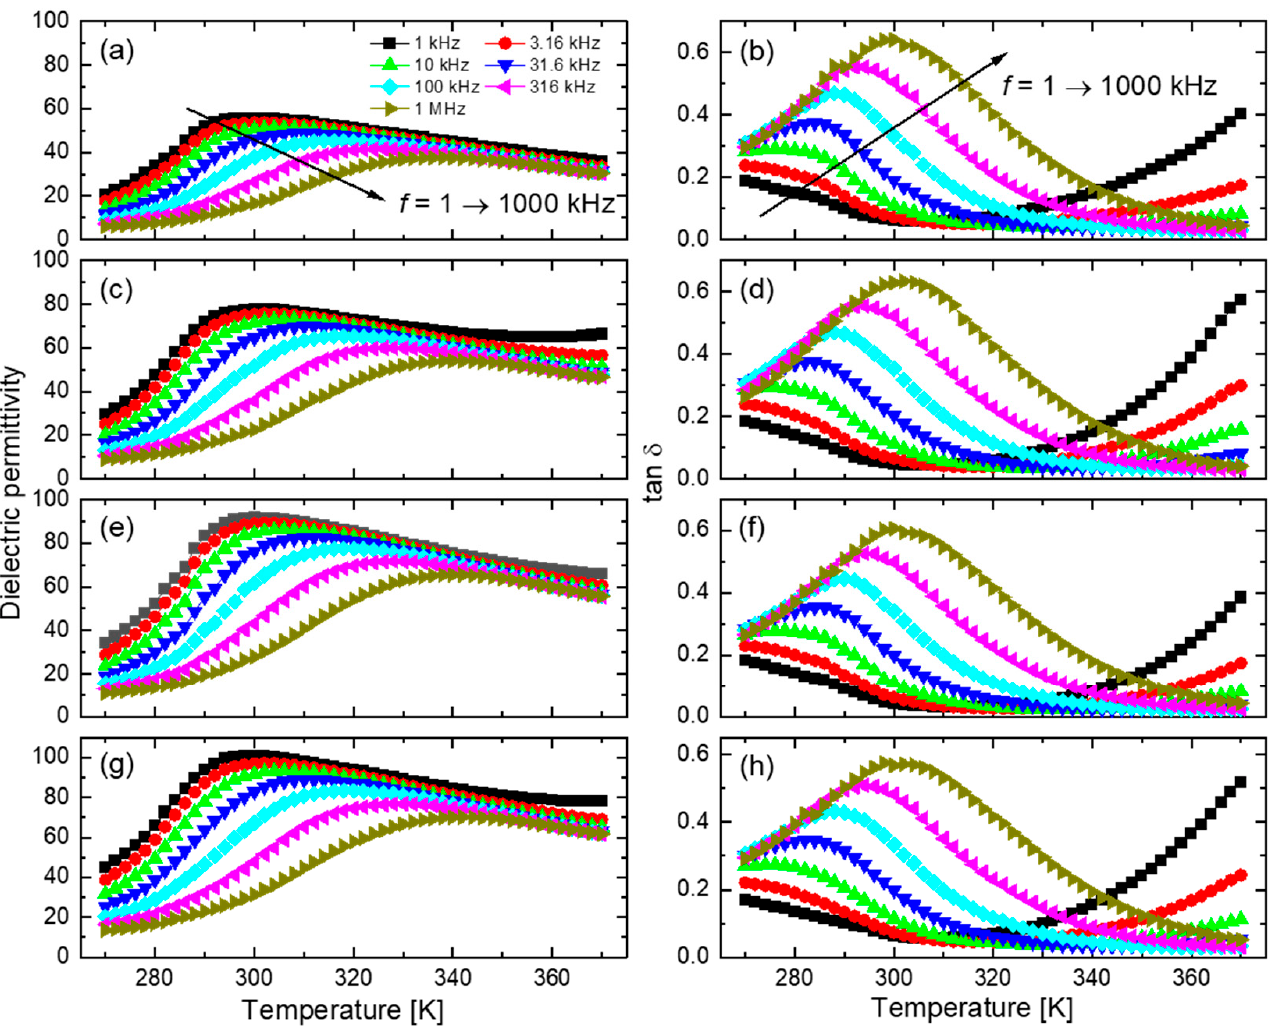
Figure 1. Temperature dependences of the real part of dielectric permittivity and dielectric loss tangent of P(VDF-TrFE-CFE) 68/32/8.5 with varying BZT nanoparticle contents, ( a , b ) 0 vol.%, ( c , d ) 1.25 vol.%, ( e , f ) 2.5 vol.%, and ( g , h ) 5 vol.%.